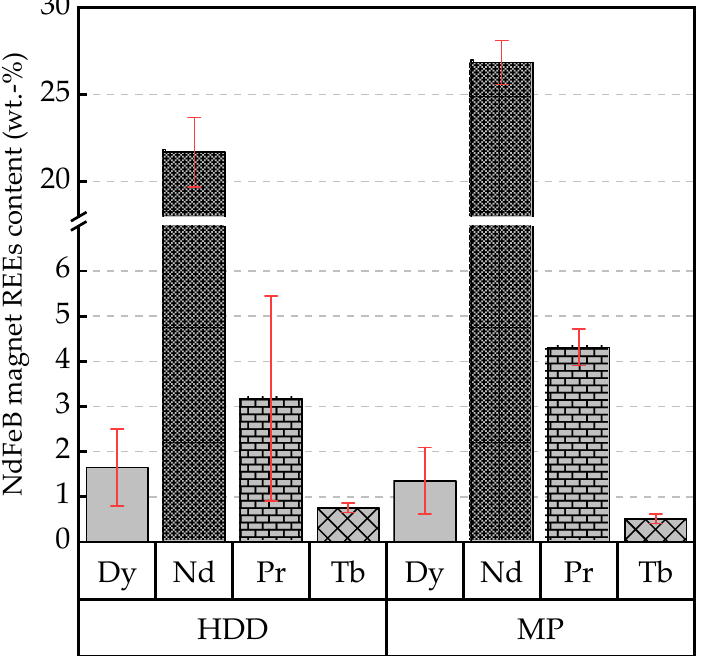
Figure 3. Rare earth element content (wt.%) in both HDD and MP NdFeB magnets within the 2005–2016 period according to the device lifespan.